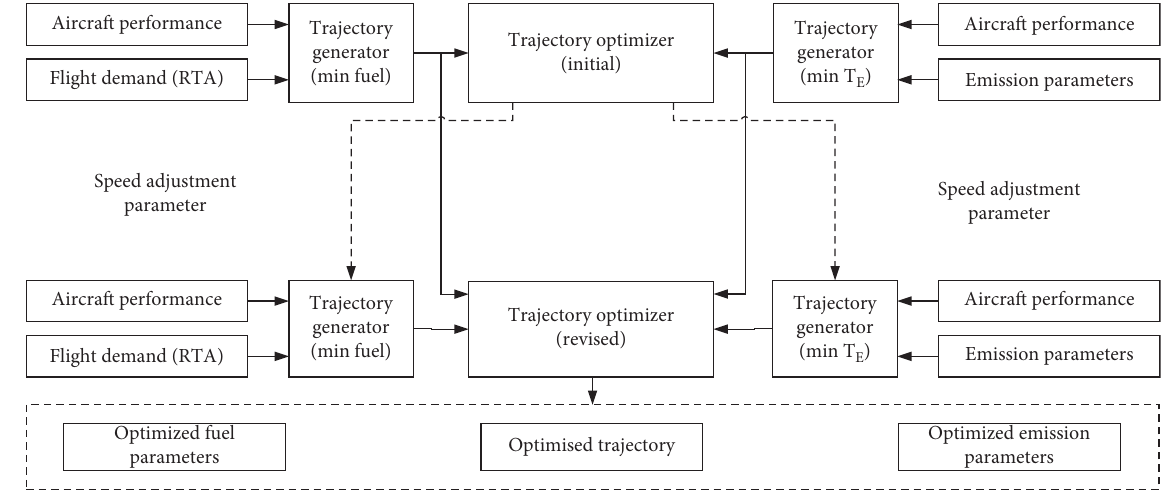
Figure 1: Problem research framework.